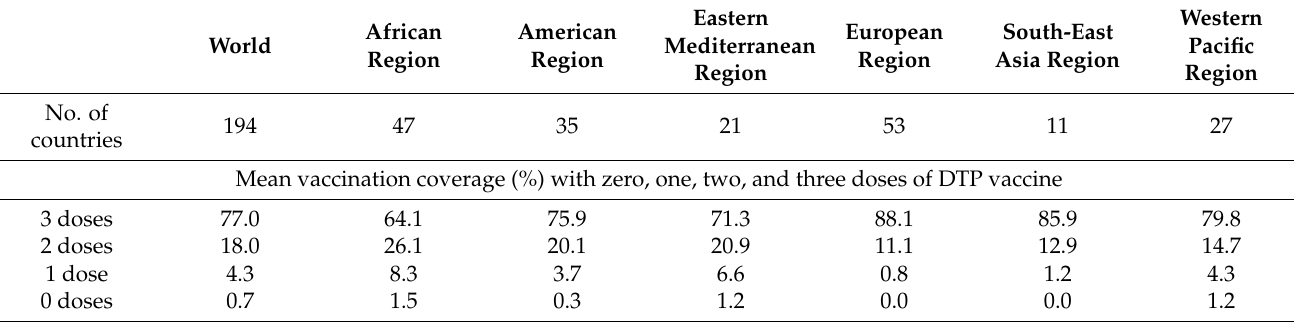
Mean prevalence (%) of individuals in the target vaccination population with vaccine-induced pertussis immunity Pertussis immunity Percentage of countries with vaccination coverage of ≥ 95% and ≥ 90% with three doses of DTP vaccine